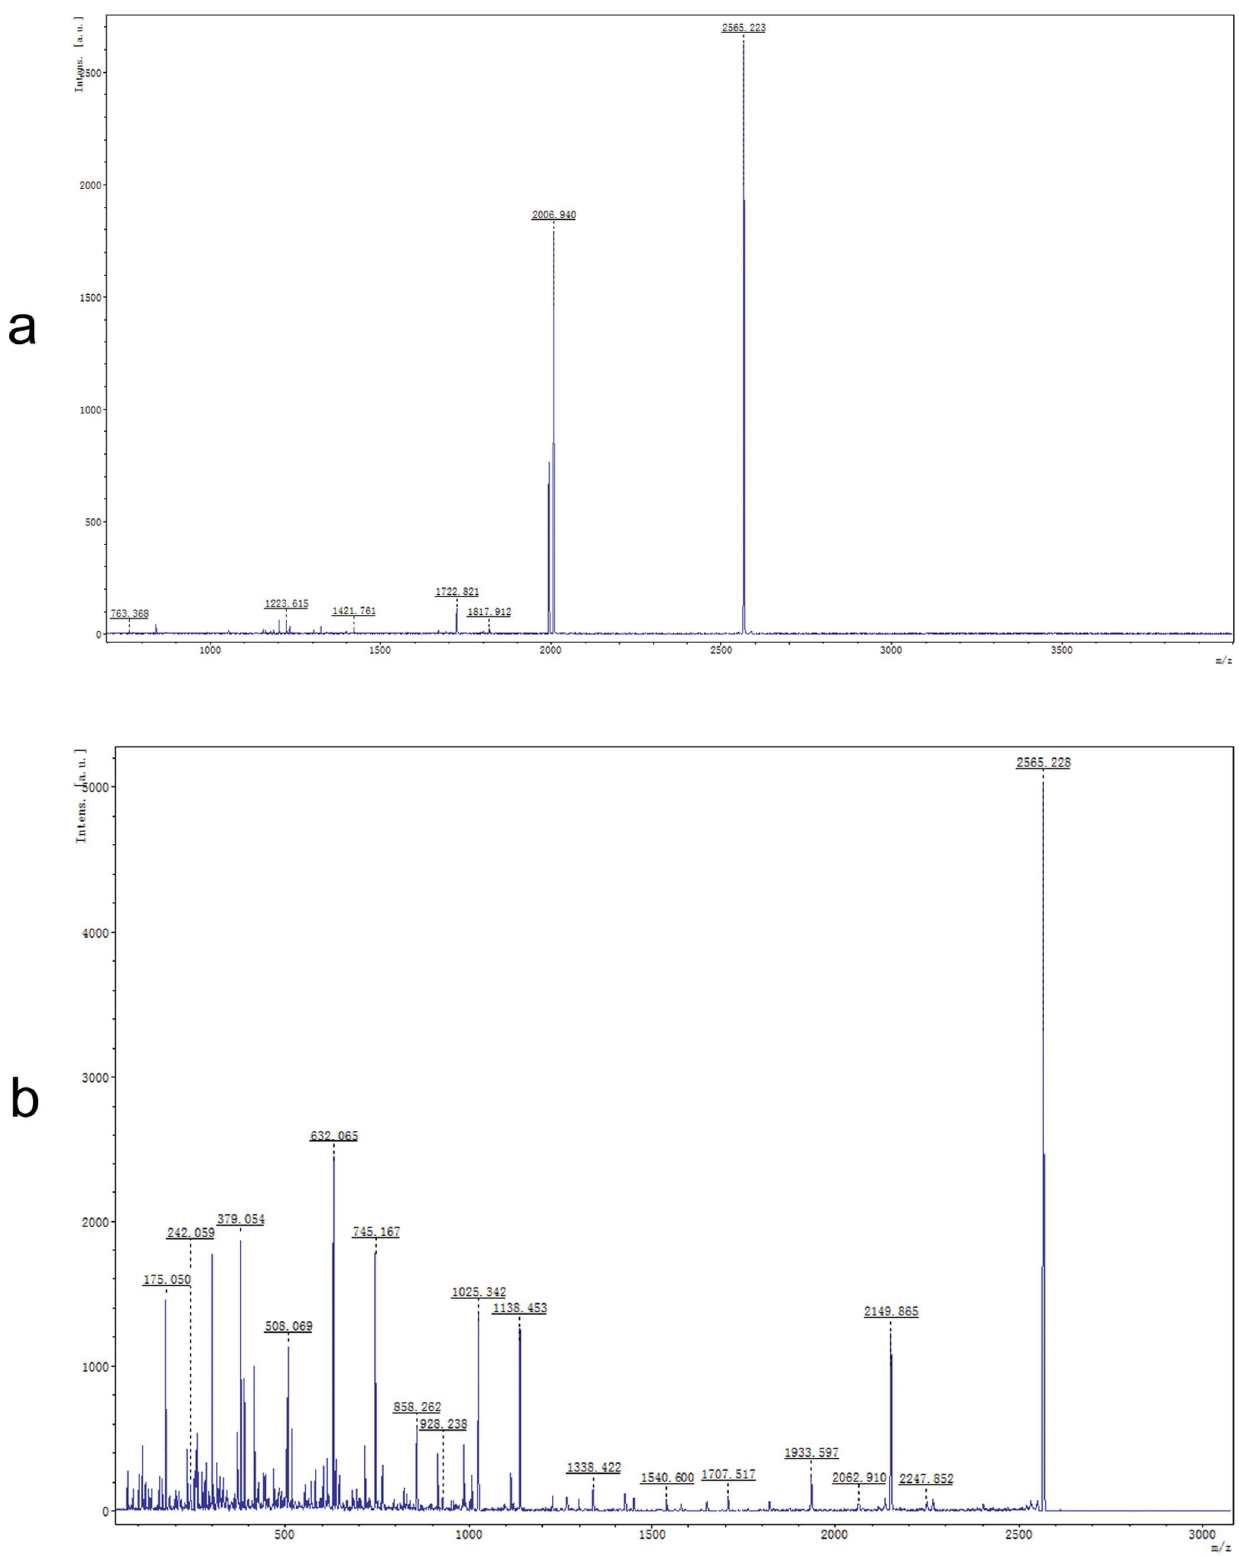
Figure 4. The MALDI-TOF/TOF-MS/MS analysis of protein spot 22. Note: The MALDI-TOF-MS peptide mass fingerprint spectrum of trypsin- digested protein (a) and its MS/MS peptide mass fingerprint spectrum of ionic peak 2565.23 (b).